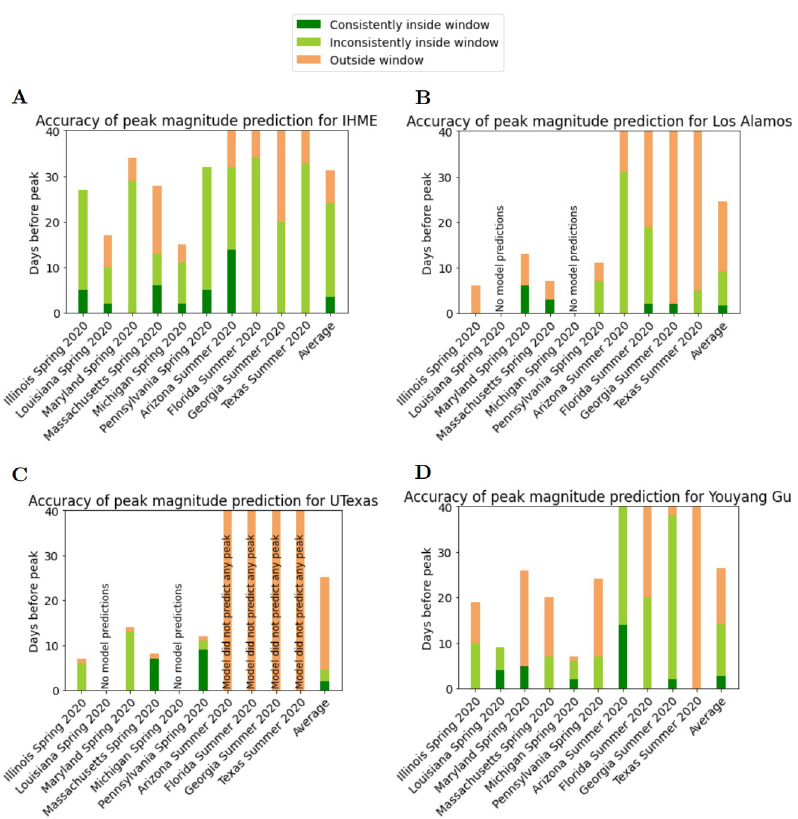
Fig 8. Visualization of predictive accuracy for magnitude of peak deaths of all Spring and Summer 2020 death peak events (see Table 2). A) IHME, B) Los Alamos, C) UTexas, and D) YYG. Each bar represents a peak event. Dark green region represents the days prior to peak that the model accurately and consistently predicted magnitude of peak (see definition of PeakMagnitude_FirstConsistent score). Orange/light green boundary represents first day model predicted magnitude of peak (see definition of PeakMagnitude_FirstAccurate